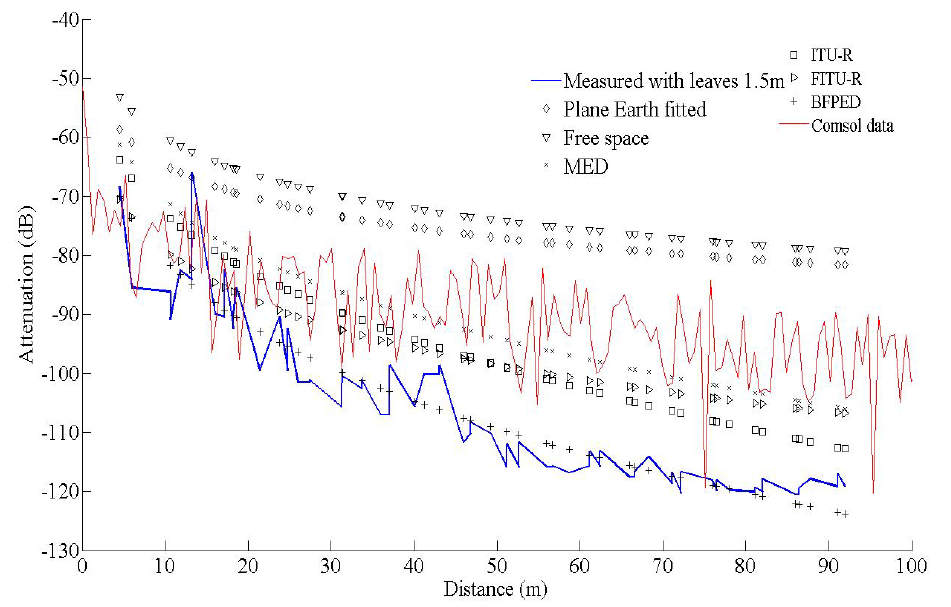
Figure 9. Comparison between empirical propagation models, measurements and data from simulation, for transmitter and receiver height at 1.5 m, with